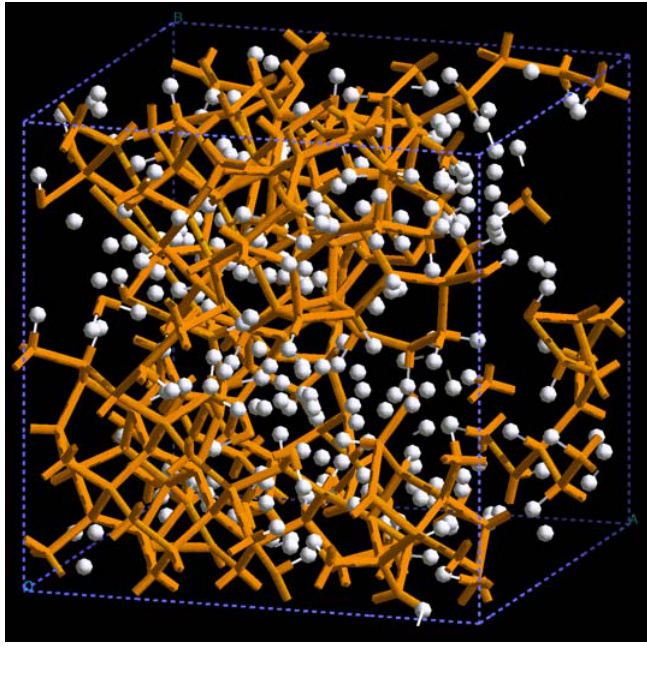
Figure 20. Starting with the relaxed porous Si structure, the dangling bonds were saturated with hydrogens displaced 1 Bohr radius along the (1, 1, 1) direction. Next the supercell was geometry